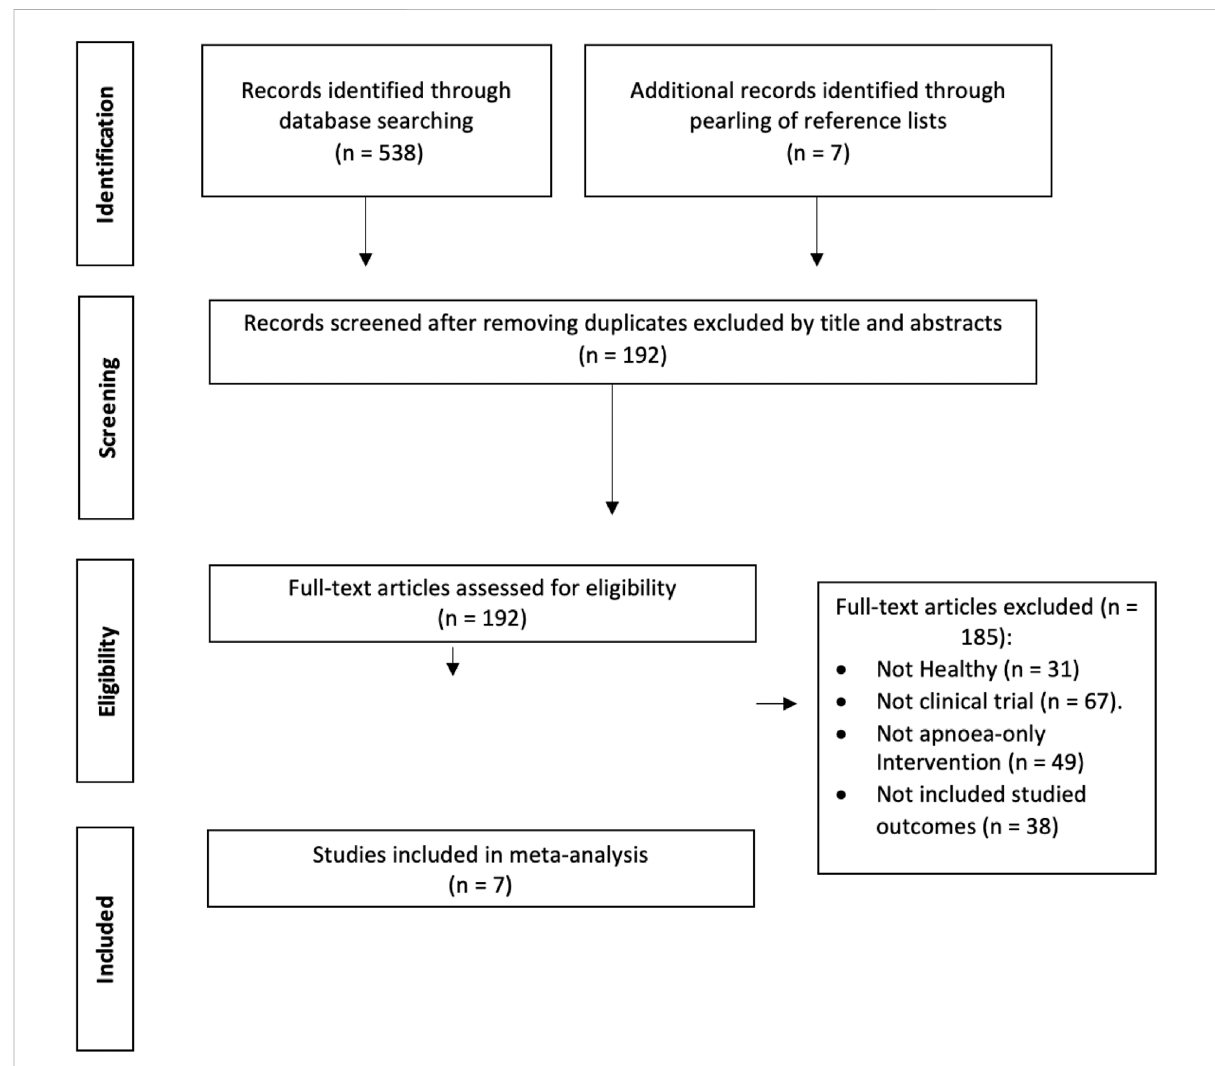
FIGURE 1 Flow chart of information through the different phases of a systematic